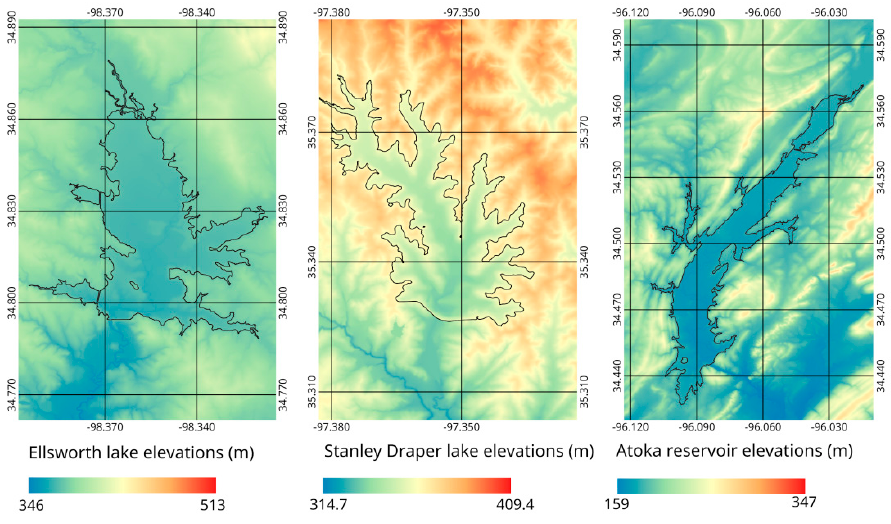
Figure 5. Terrain elevation of Oklahoma lakes.